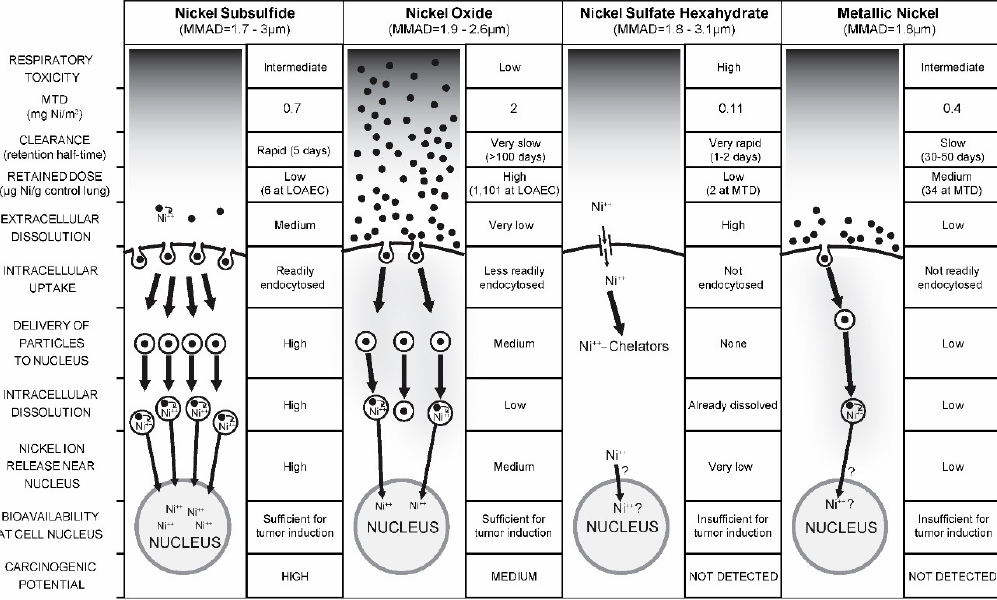
Figure 2. Summary of the bioavailability model for nickel carcinogenicity potential in humans and animals. According to this model, the interplay of factors like respiratory toxicity, maximum tolerated dose in animals, lung clearance, and delivery of sufficient nickel ions to the nuclei of respiratory epithelial cells influence the carcinogenicity observed with nickel in animal inhalation studies. DMT—Divalent Metal Transporter. Reproduced with permission from [10], Taylor & Francis Ltd.